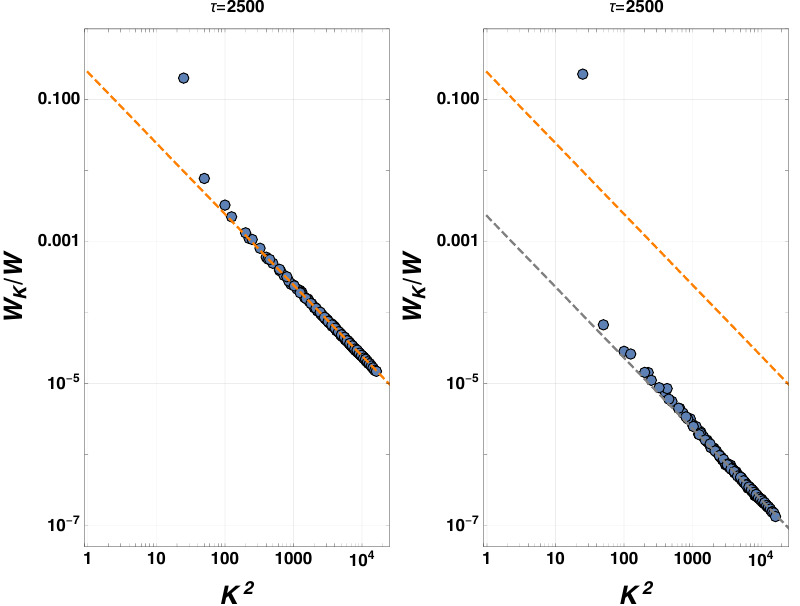
Figure 8. Case A2. Left-hand panel: inviscid. Right-hand panel: viscous. Plots of the averaged W K / W as a function of K 2 , at τ = 2500. As in Figure 5, the orange dashed line indicates the behavior ∼ 1/ K 2 of the non viscous regimes and the gray one corresponds to the viscous